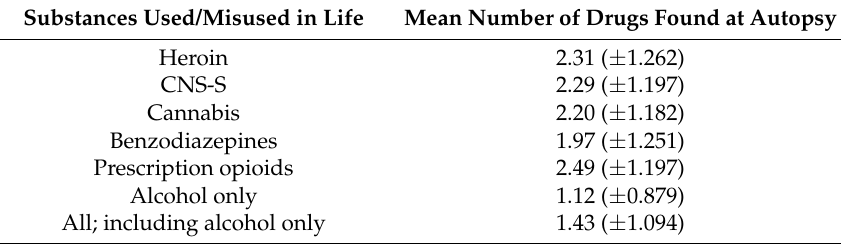
Table 4. Mean number of drugs found at autopsy by drug used in